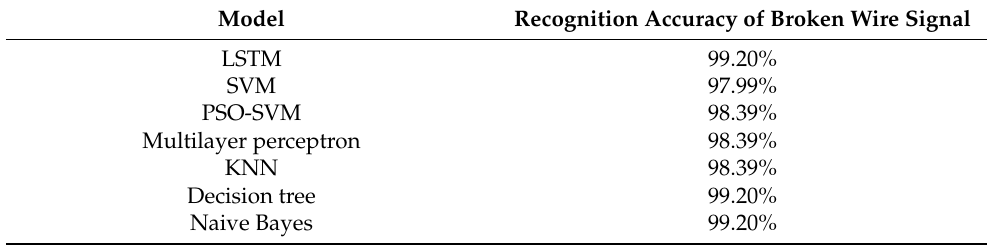
Table 7. Recognition accuracy performance (simulated signal for training, and measure signals for test set).